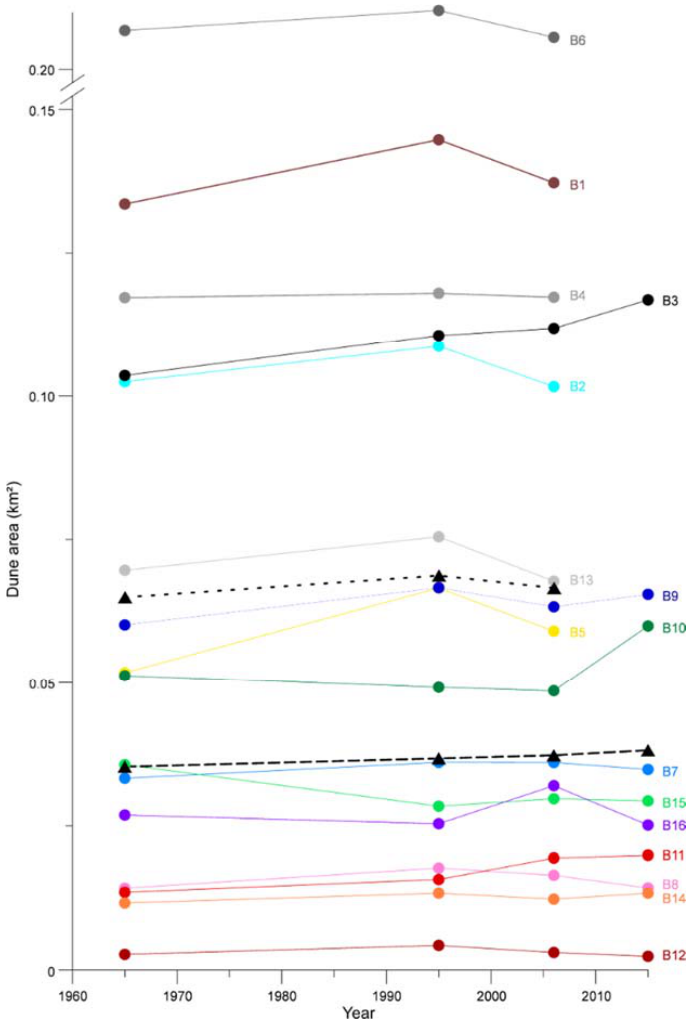
Figure 7. Changes in dune area over time. The black dotted line represents the average of all dunes B1–B16, while the dashed line shows the average of only those dunes still entirely intact in 2015.